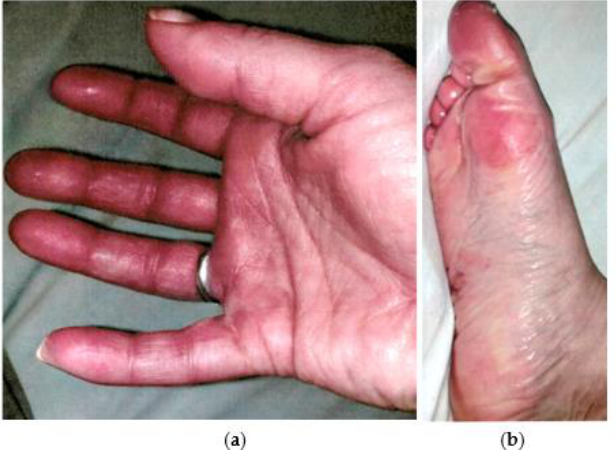
Figure 1. Pictures of hands and feet at admission. The patient showed swelling and redness of the right palm and fingers ( a ), as well as the sole of the right foot and toes ( b